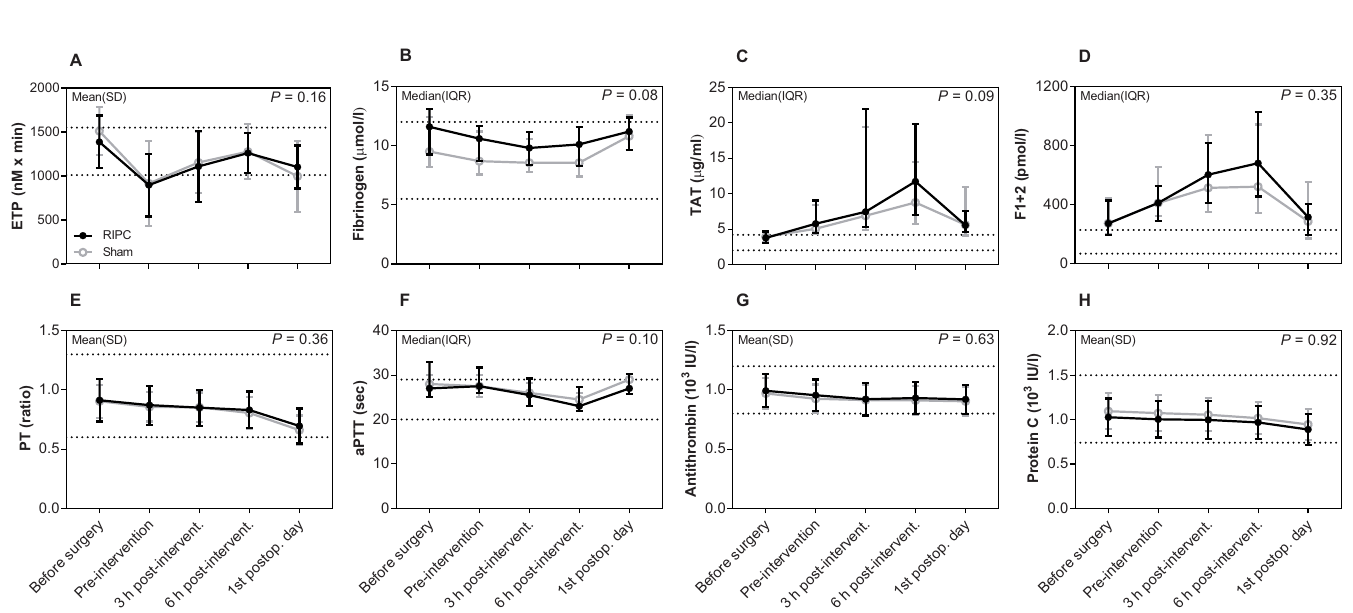
Fig 4. Thrombin generation, secondary hemostasis, and natural anticoagulants. Data are shown as mean ± SD or median with IQR. Lines indicate common reference intervals for healthy men and women from our laboratory if available. Reference intervals for TAT and F1+2 were provided by the manufacturer. P -values represent the multivariate repeated measures ANOVA. Mixed-model was used for ETP. Missing data: Thrombin generation produced flat curves in 4 samples obtained pre-intervention (3 RIPC, 1 sham) and in 4 samples obtained on the first postoperative day (3 RIPC, 1 sham). Abbreviations: aPTT: activated partial thromboplastin time, ETP: endogenous thrombin potential, F1+2: prothrombin fragment 1+2, PT: prothrombin time, RIPC: remote ischemic preconditioning, TAT: thrombin- antithrombin complex.